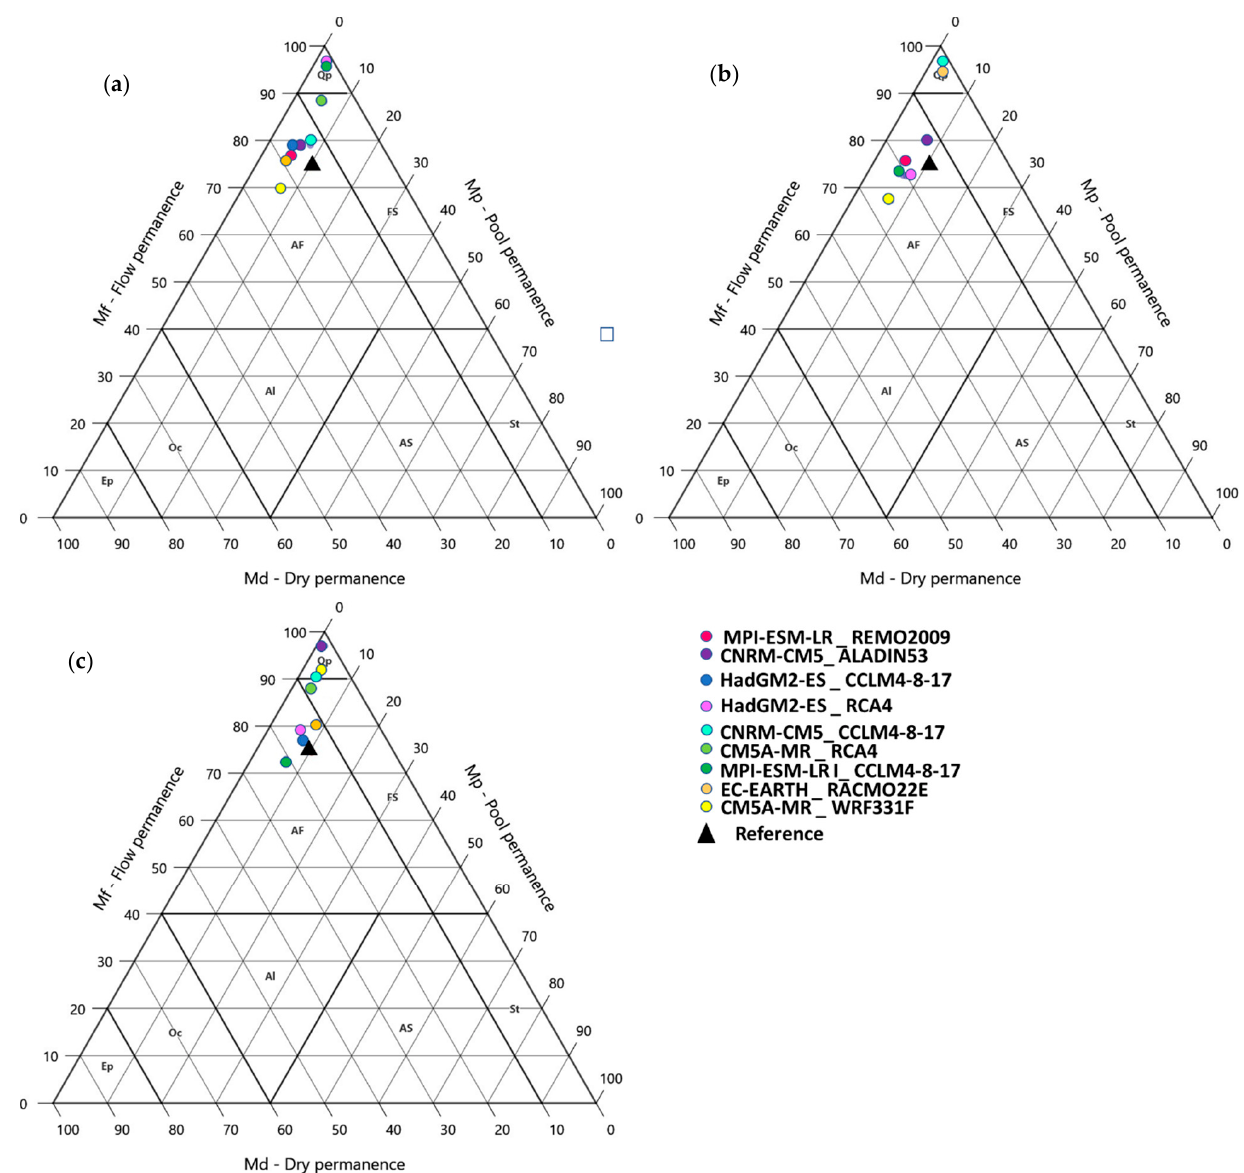
Figure 16. FDP plots for the diverse sources: ( a ) RCP 4.5; ( b ) RCP8.5; and ( c ) historical. Perennial (Pe), Quasi-perennial (Qp), Fluent-Stagnant (FS), Alternate-Fluent (AF), Stagnant (St), Alternate-Stagnant (AS), Alternate (Al), Occasional (Oc), Episodic (Ep).